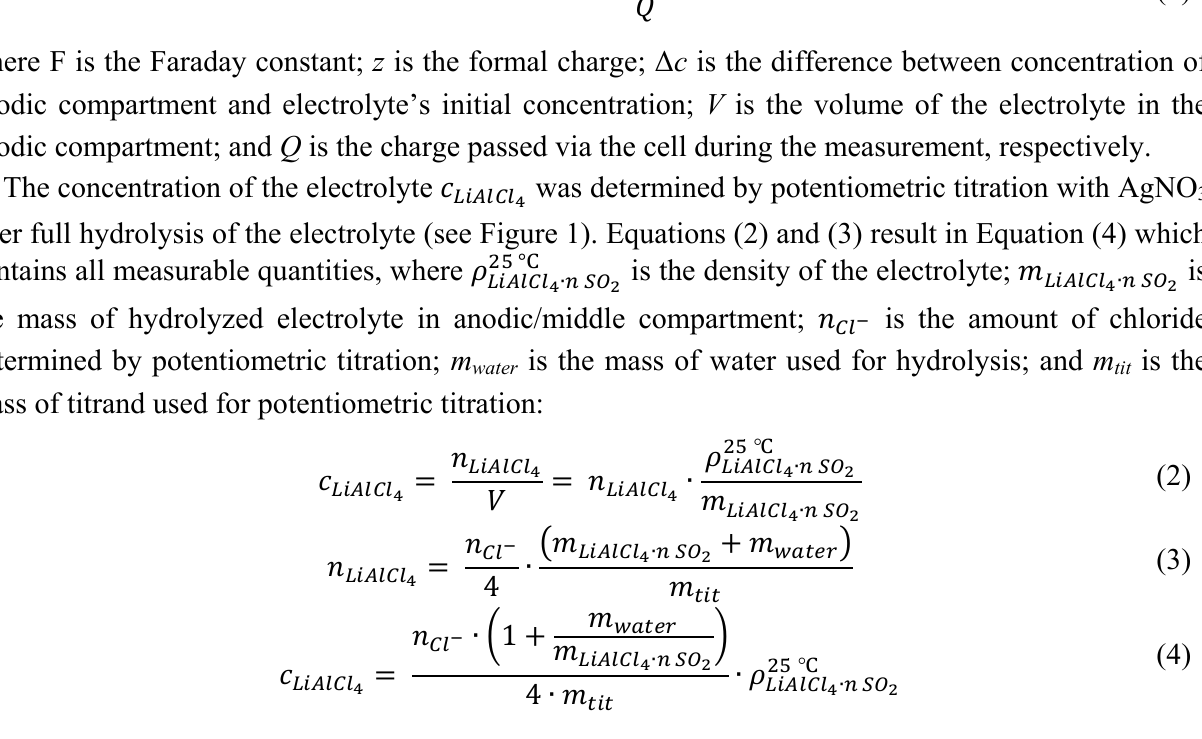
Figure 1. Typical titration graph, potential E vs. volume of the consumed silver salt